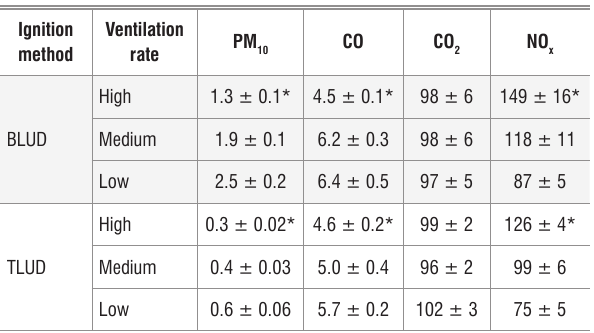
Table 5: Emission factors (mg/MJ) as a function of ventilation rates for the top-lit updraft (TLUD) and bottom-lit updraft (BLUD) ignition methods ( n